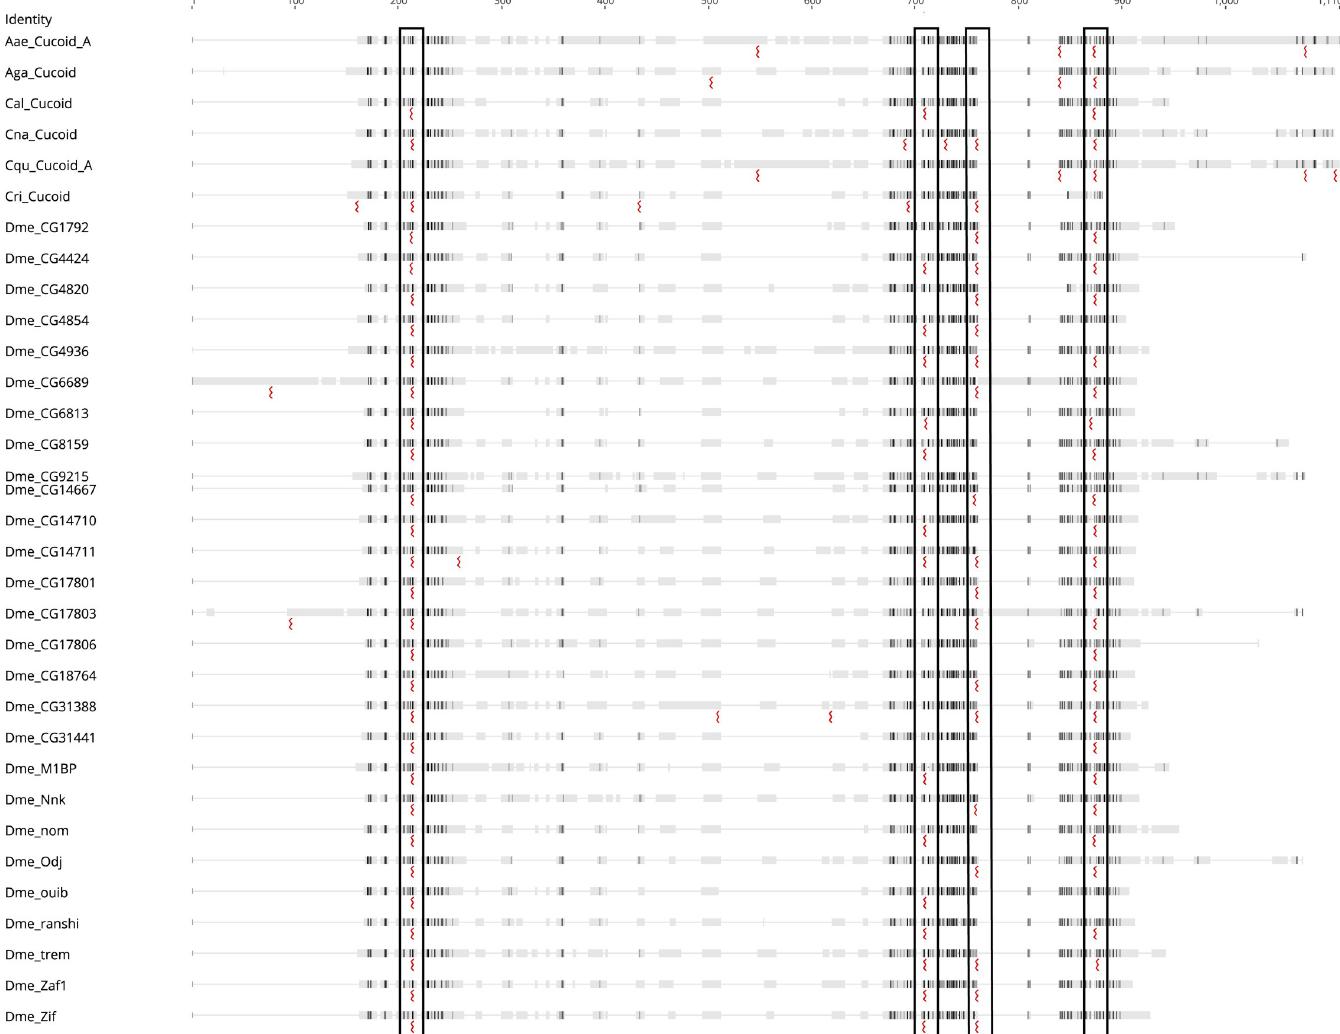
Fig 4. Conservation of Cucoid introns. Multiple sequence alignment of Cucoid orthologs from lower dipterans and Cucoid clade members of D . melanogaster . Conserved intron positions are boxed, and the red zigzags represent the splicing points. Similarity of aligned amino acids was assessed using the Blosum62 matrix with black representing 100% similarity, dark grey 80–100% similarity, light grey 60–80% similarity, and white less than 60% similarity.